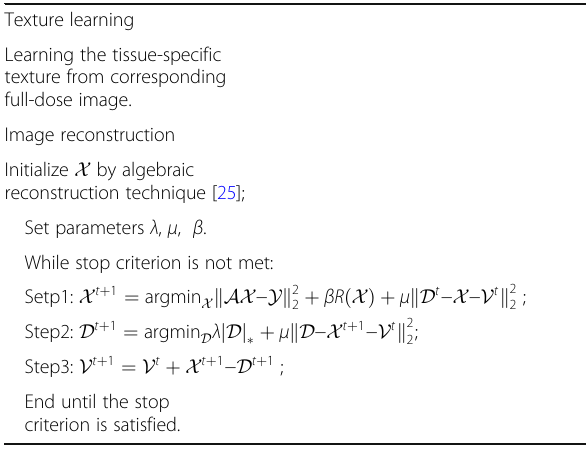
Table 1 Workflow for the proposed low rank texture prior algorithm Texture learning